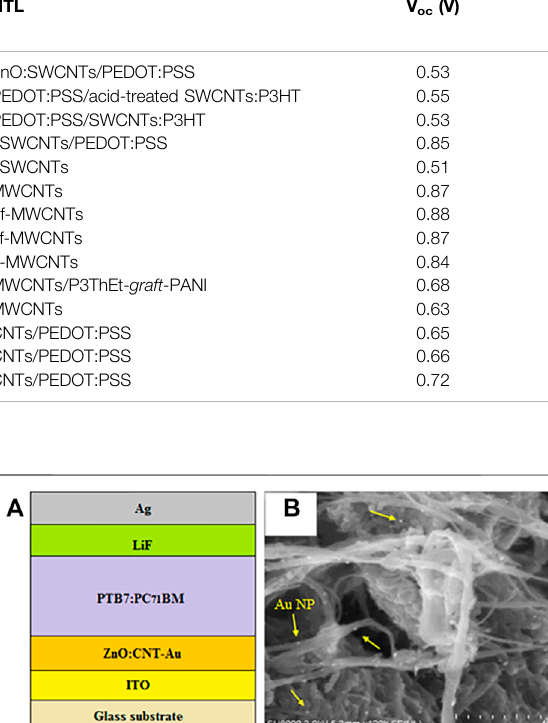
TABLE 3 | Photovoltaic parameters of OSCs employing CNT-based HTLs. HTL